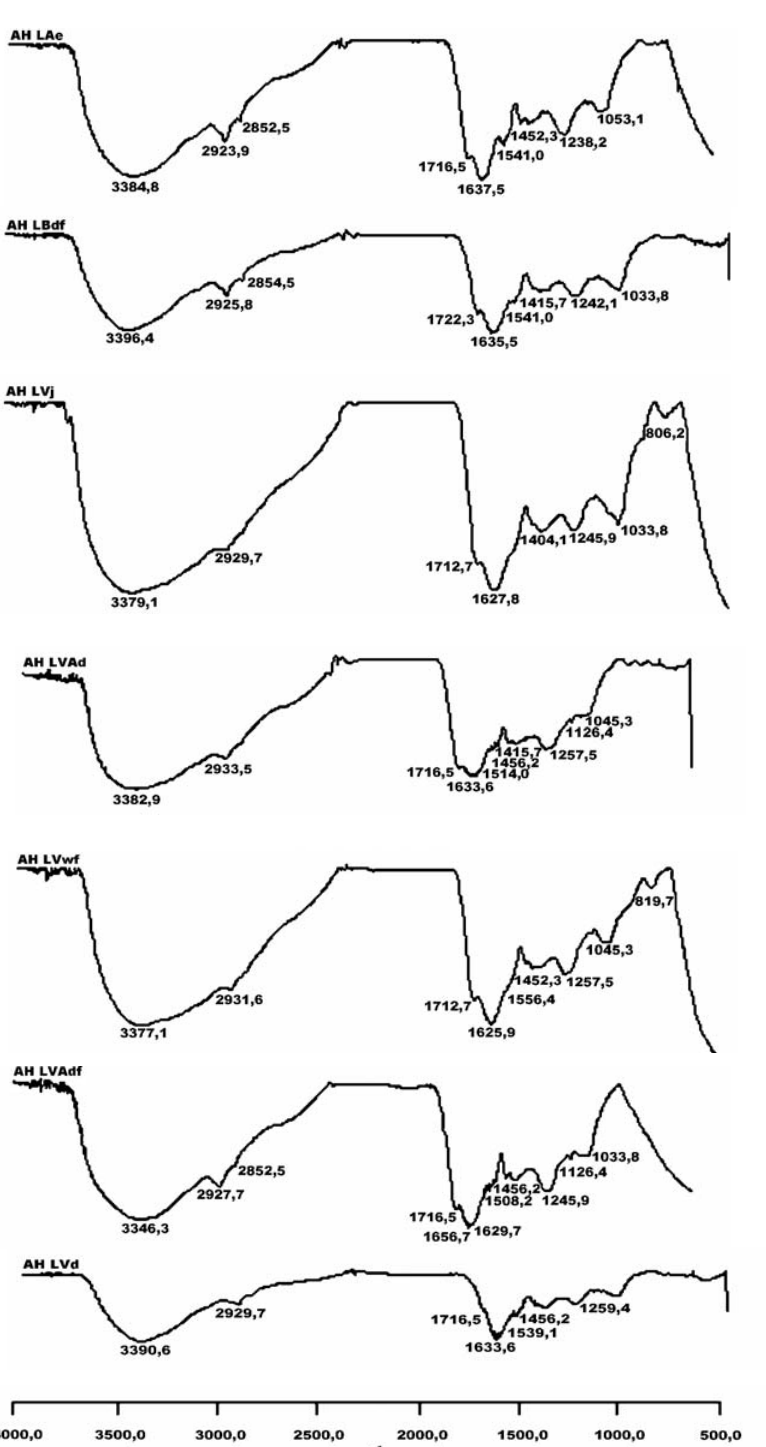
Figura 1. Espectros na região de infravermelho obtidos com transformada de Fourier de ácidos húmicos (AH) isolados do horizonte superficial dos sete Latossolos